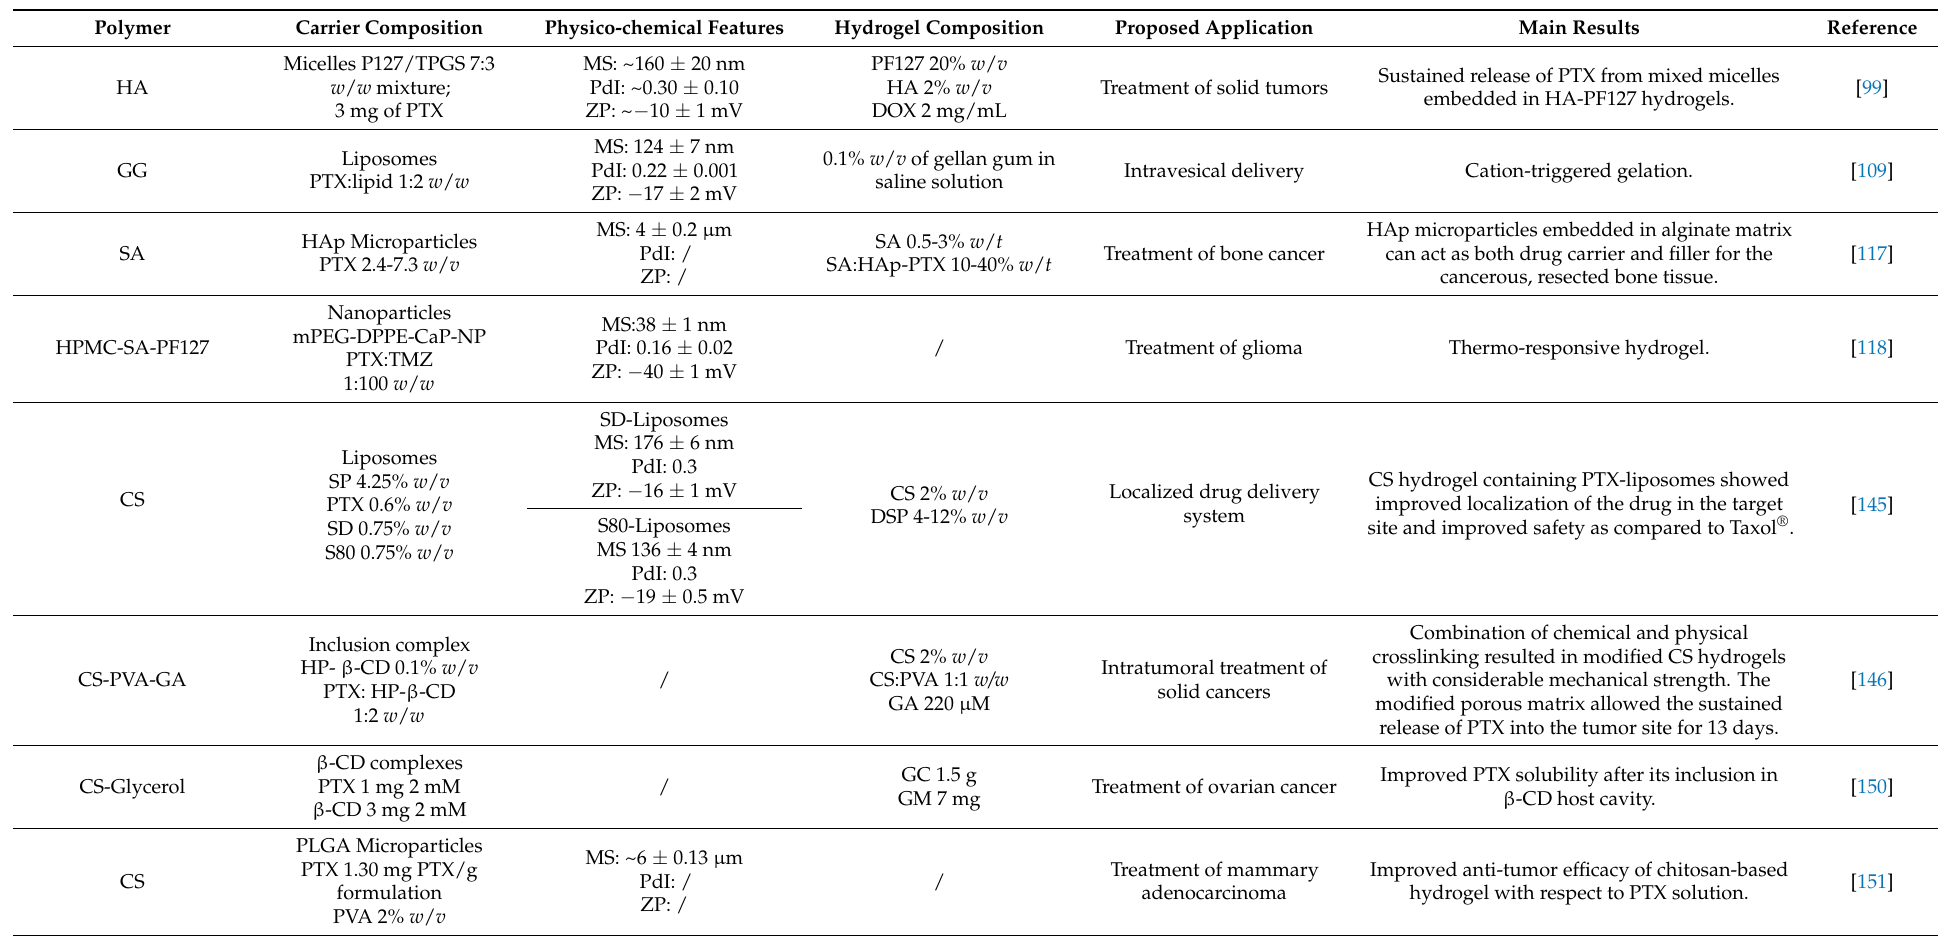
Table 1. Composition and physico-chemical properties of PTX-loaded micro/nanosystems embedded in polysaccharide-based